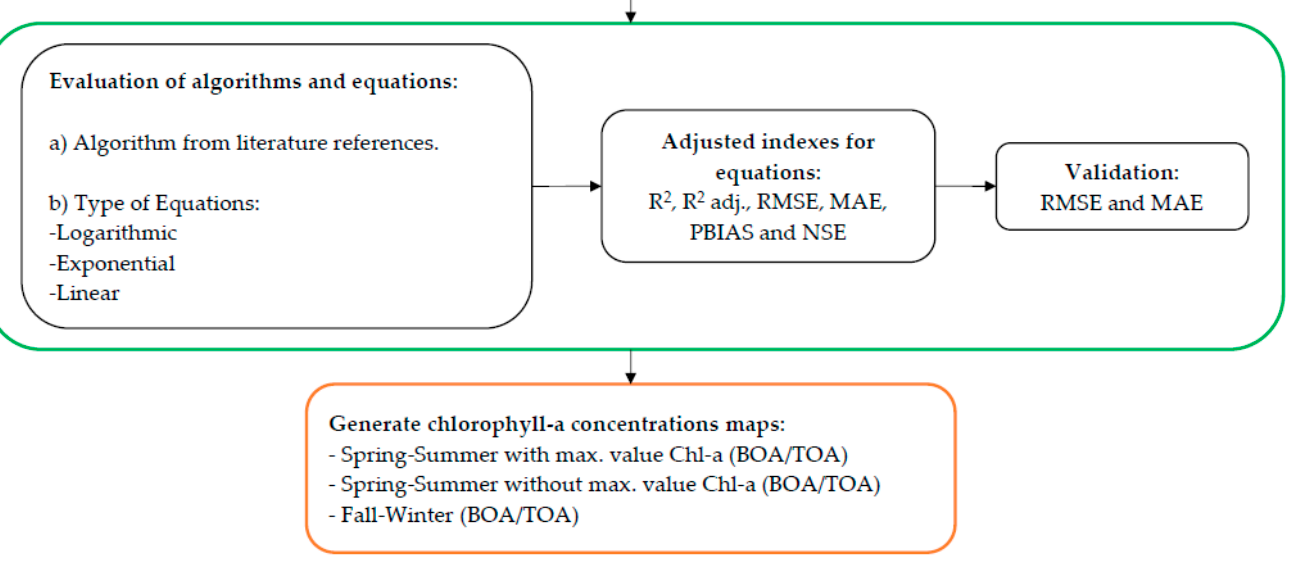
Figure 3. Schematic diagram of the methodology applied in this study.